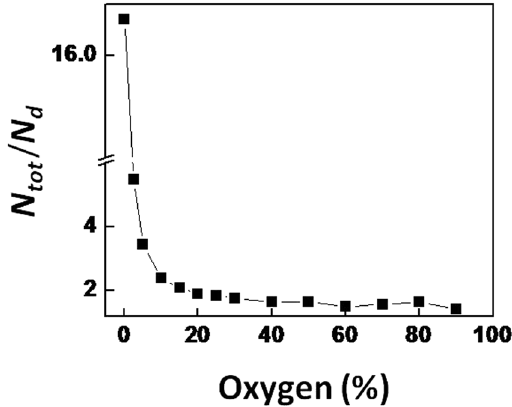
Figure 5. The N tot / N d ratio at different external O 2 concentrations. This ratio is dimensionless and describes the characteristics of nitrogenase activity in the heterocyst. The ratio indicates the contribution of photosynthesis to nitrogenase activity. Extrapolation shows that at 97% O 2 this ratio equals 1, meaning that light is no longer required to achieve maximum nitrogenase activity. At low O 2 concentration this ratio becomes very large because nitrogenase activity is fully driven by photosynthesis and N d approaches